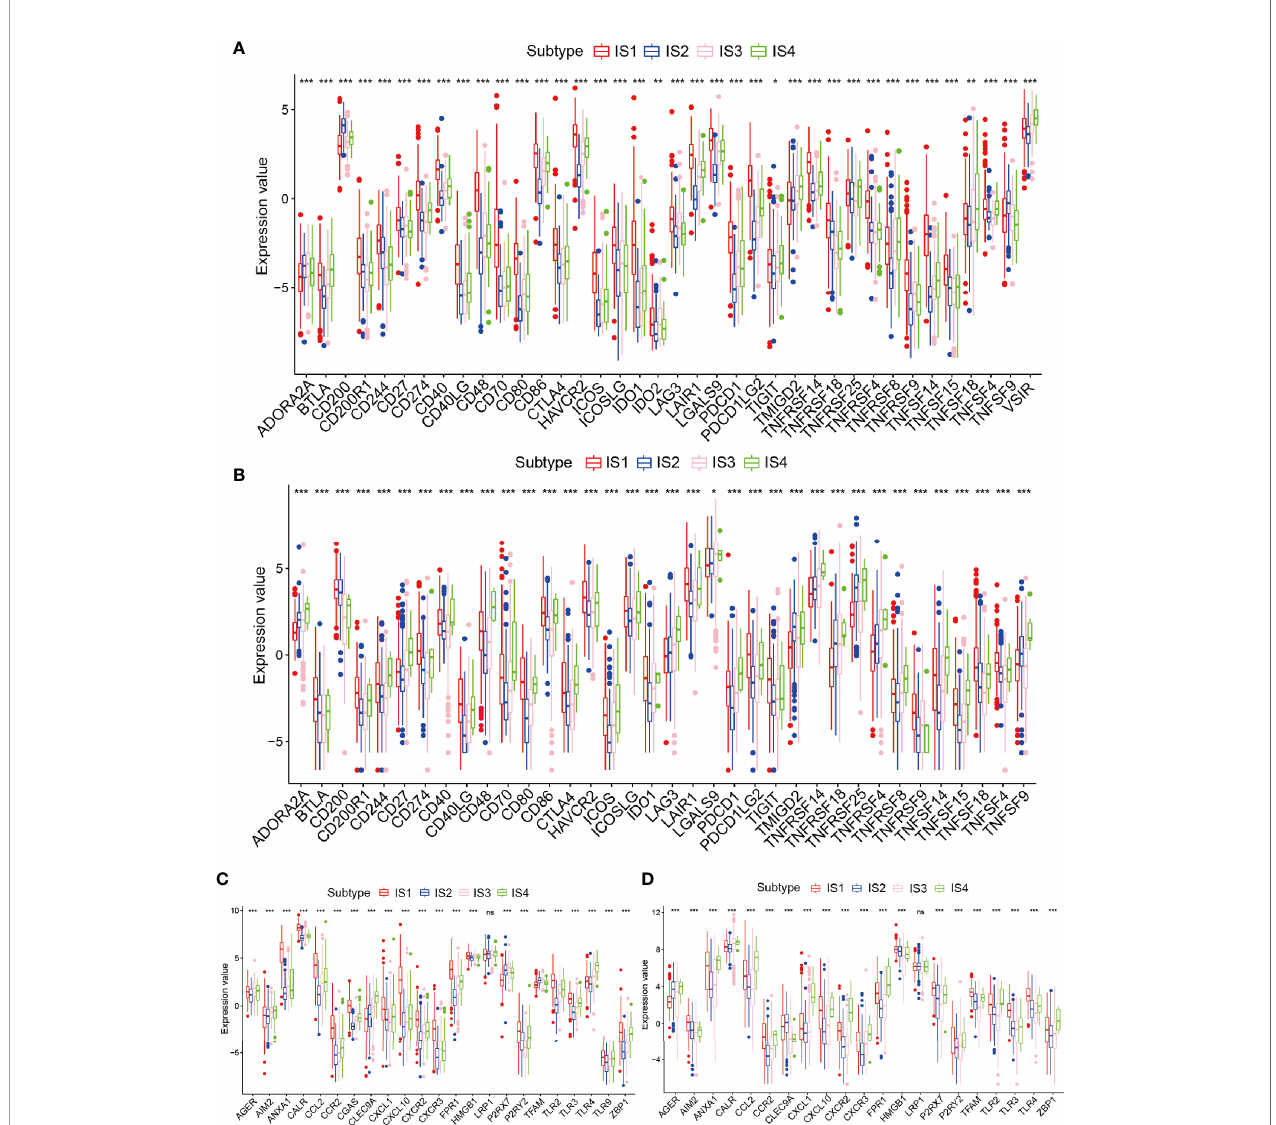
FIGURE 5 | Relationships among the immune subtypes and ICPs and ICD modulators. (A, B) Distribution of ICP genes among the glioma immune subtypes in the TCGA and CGGA cohorts. (C, D) Distribution of ICD genes between the glioma immune subtypes in the TCGA and CGGA cohorts. *p < 0.05, **p < 0.01, ***p < 0.001 and ns, non-signi fi